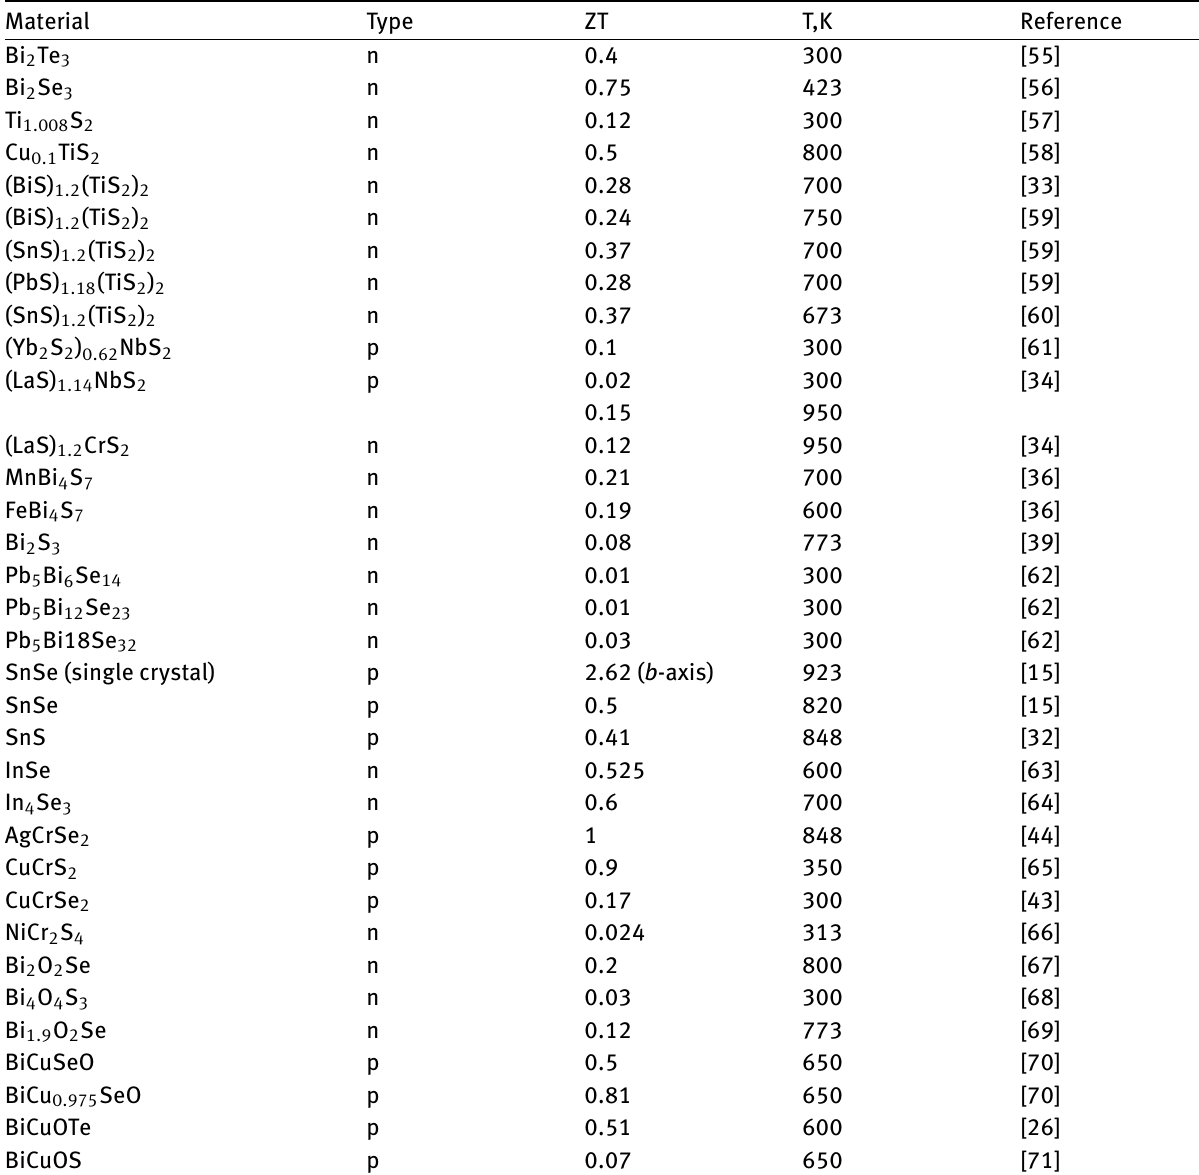
Table 1: Layered chalcogenide materials with their ZT